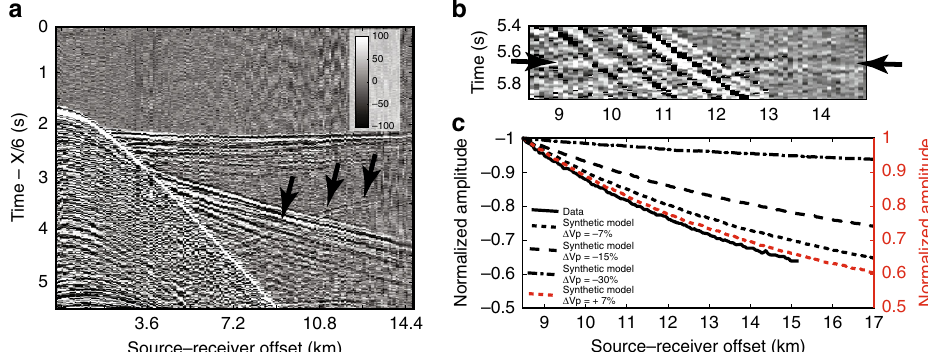
Fig. 5 Relative amplitude versus offset variation. a Observed OBH 501 gather with a reduced velocity of 6 km/s highlighting the part of re fl ection event (black arrows) used for the amplitude versus offset (AVO) analyses. b Normal moveout corrected gather used for the AVO study. Black arrows highlight the mantle re fl ection. c Relative amplitude versus offset curves for real data (thick black) and synthetic data with different velocities ( − 7, − 15, − 30, + 7%) in a 300-m-thick layer for the upper layer. Note that for the increase in velocity, the variation is from + 1 to + 0.5 and for the decrease in velocity the variation is from − 1 to −